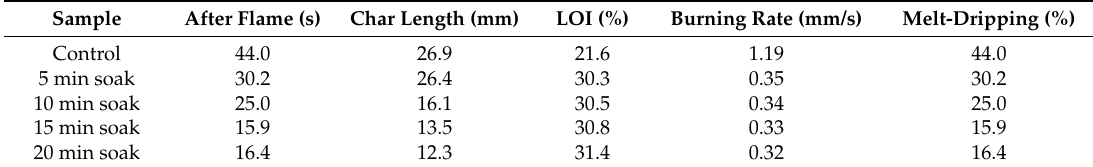
Table 6. Vertical burn test data for FR polyester sol-gel composites prepared using layer-by-layer (LbL) assembly.